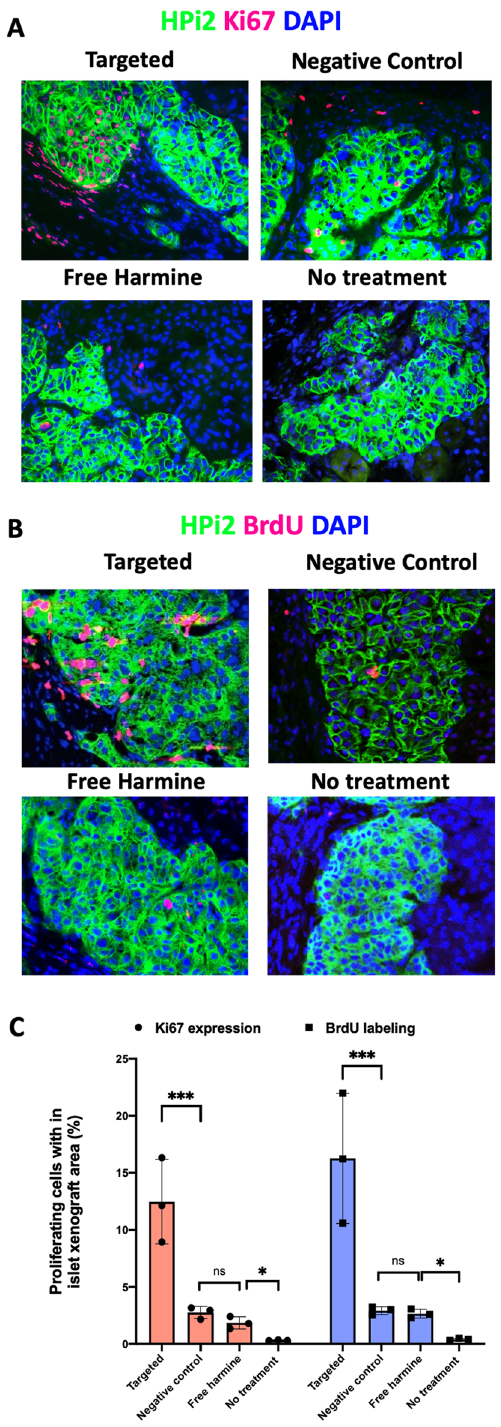
Figure 6. Representative human islet xenograft sections co-immunostained with HPi2 (green) and antibodies against ( A ) Ki67 (red) or ( B ) BrdU (red) a to measure proliferation in the transplanted islets upon treatment with harmine loaded targeted nanocarriers, harmine loaded negative control nanocarriers, harmine, and no treatment. The sections were counterstained with DAPI (blue). ( C ) Proliferating human islet cells within the xenograft from individual mice (n = 3) in each treatment group. Results are the means ± standard deviation for the percent proliferating cells of total HPi2 positive cells for each animal. Data were confirmed to be normally distributed by the Shapiro–Wilk normality test and analyzed using one-way analysis of variance (ANOVA) followed by Dunnett’s test for multiple comparisons at α = 0.05. * and *** denotes p-value < 0.05 and p < 0.001